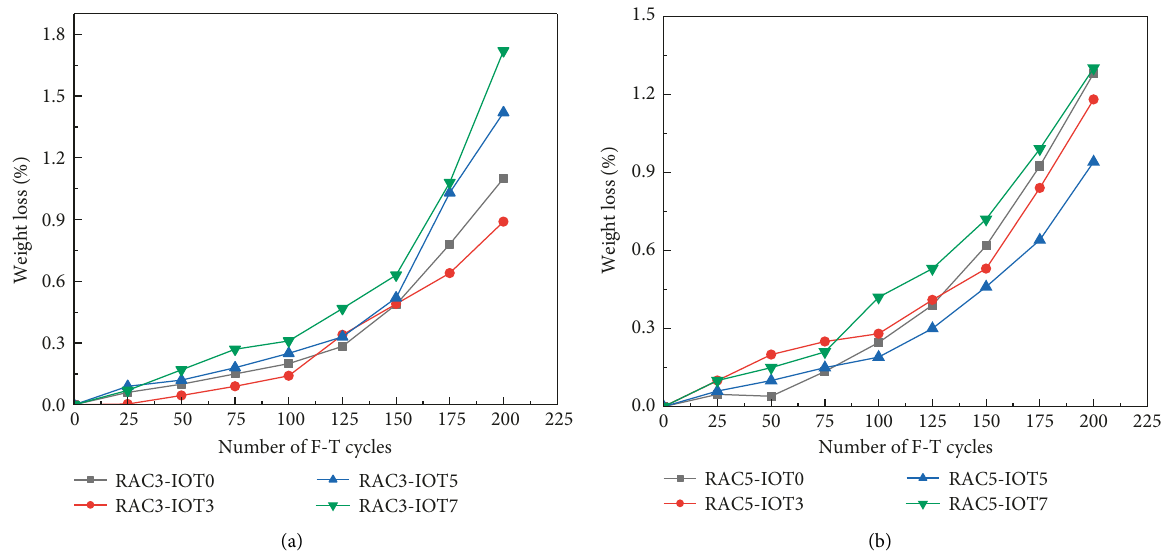
Figure 8: Mass loss rate of iron ore tailings recycled aggregate concrete during F-T cycle: (a) the dosage of RCA is 30%; (b) the dosage of RCA is 50%.